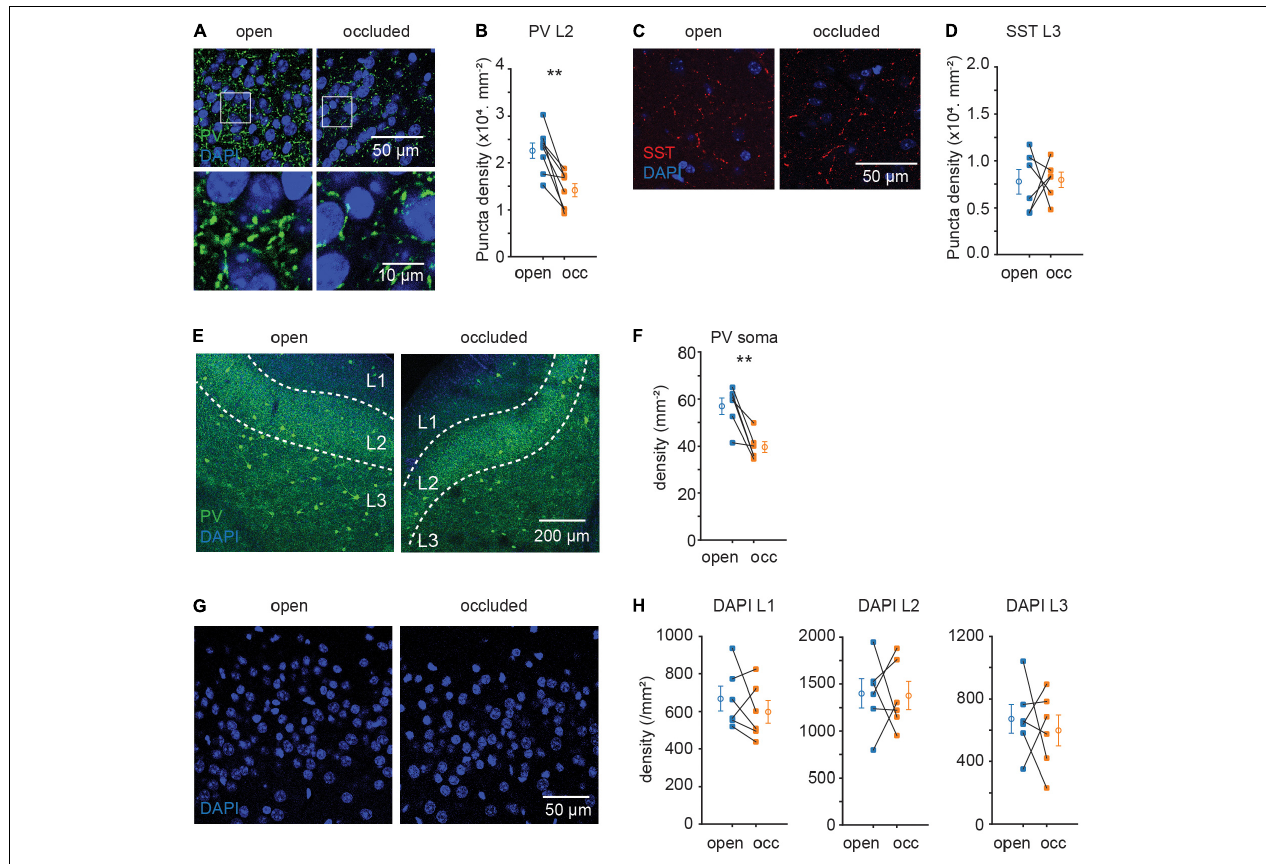
FIGURE 2 | Sensory deprivation induced selective plasticity in PV neurons. (A) Representative images of PV puncta in layer 2 of APC. (B) Quantification of PV puncta density in layer 2 of APC. ( p = 0.002, N = 8) (C) representative images of SST puncta in layer 3 of APC. (D) Quantification of SST puncta density in layer 3 of APC. ( p = 0.93, N = 6) (E) representative images of PV neuron in APC. (F) Quantification of PV neuron density in APC. ( p = 0.008, N = 6) (G) representative images of DAPI in layer 2 of APC. (H) Quantification of cell density in APC. (L1: p = 0.356, N = 6; L2: p = 0.921, N = 6; L3: p = 0.638, N = 6). n = 3 repeats of experiments were performed. Paired t -test was used for all